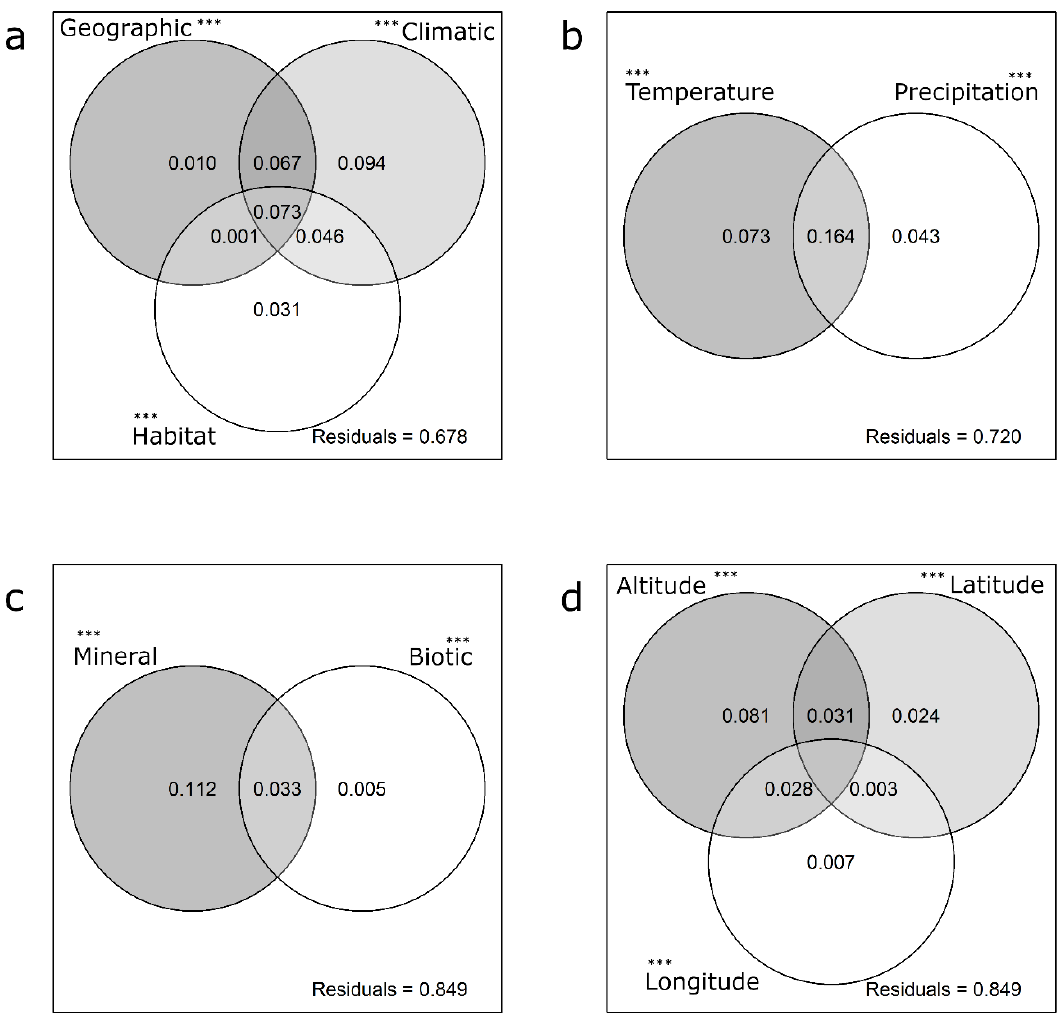
Figure 3. Results of variance partitioning on macroinvertebrate assemblage matrix. Panel ( a ) shows the results for the three considered groups of variables together while other panels show the detailed results for each group. Panel ( b ) refers to climatic variables, panel ( c ) to habitat variables and panel ( d ) to geographic ones. Values displayed are the adjusted R 2 and negative values are not shown. The unexplained portion is shown in the bottom right of panels (Residuals). Significance of the pure effects are show as asterisks. *** p < 0.001.